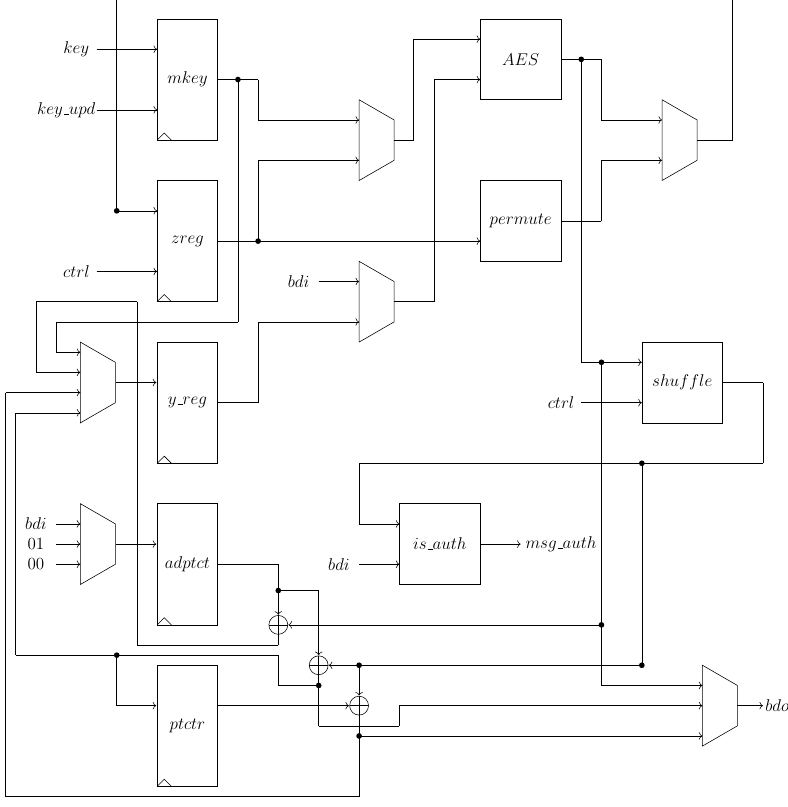
Figure 10. COMET architecture for 8 bit and 32